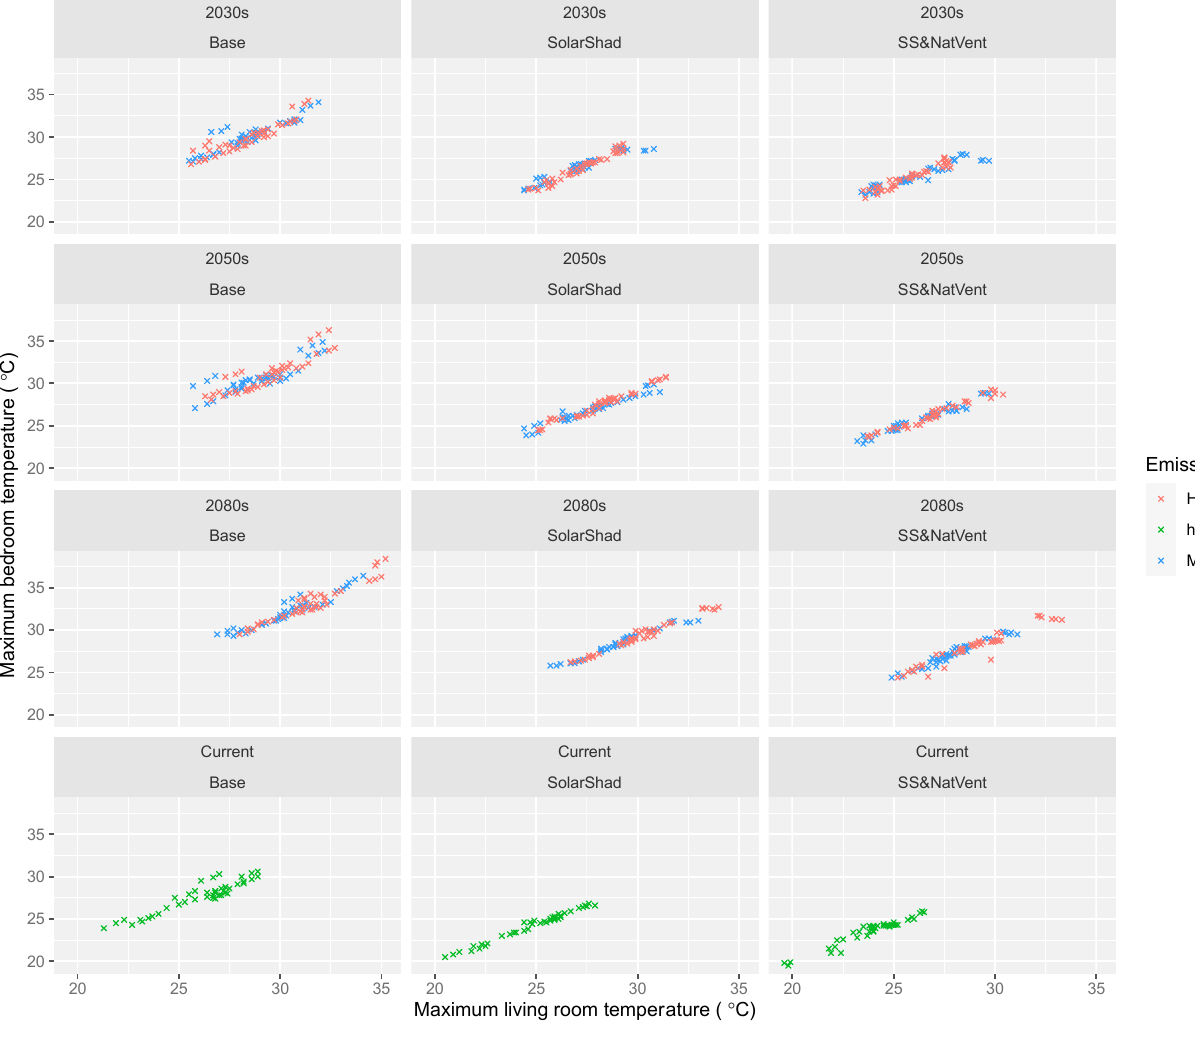
Figure 13. Scatterplots of maximum bedroom temperatures against maximum living room tempera- tures under different cases for all regions, house types, and building operation. The geographical variation in overheating is shown in Figure 14. For each cell, the left-hand, centre, and right-hand maps show base case, solar shading, and solar shading plus ventilation operation, respectively. Operation clearly has a large effect on behaviour. Southern areas have the most overheating, and western regions tend to have more than those to the east of them. Surprisingly, northern Scotland has more overheating than eastern Scotland, which is more to the south